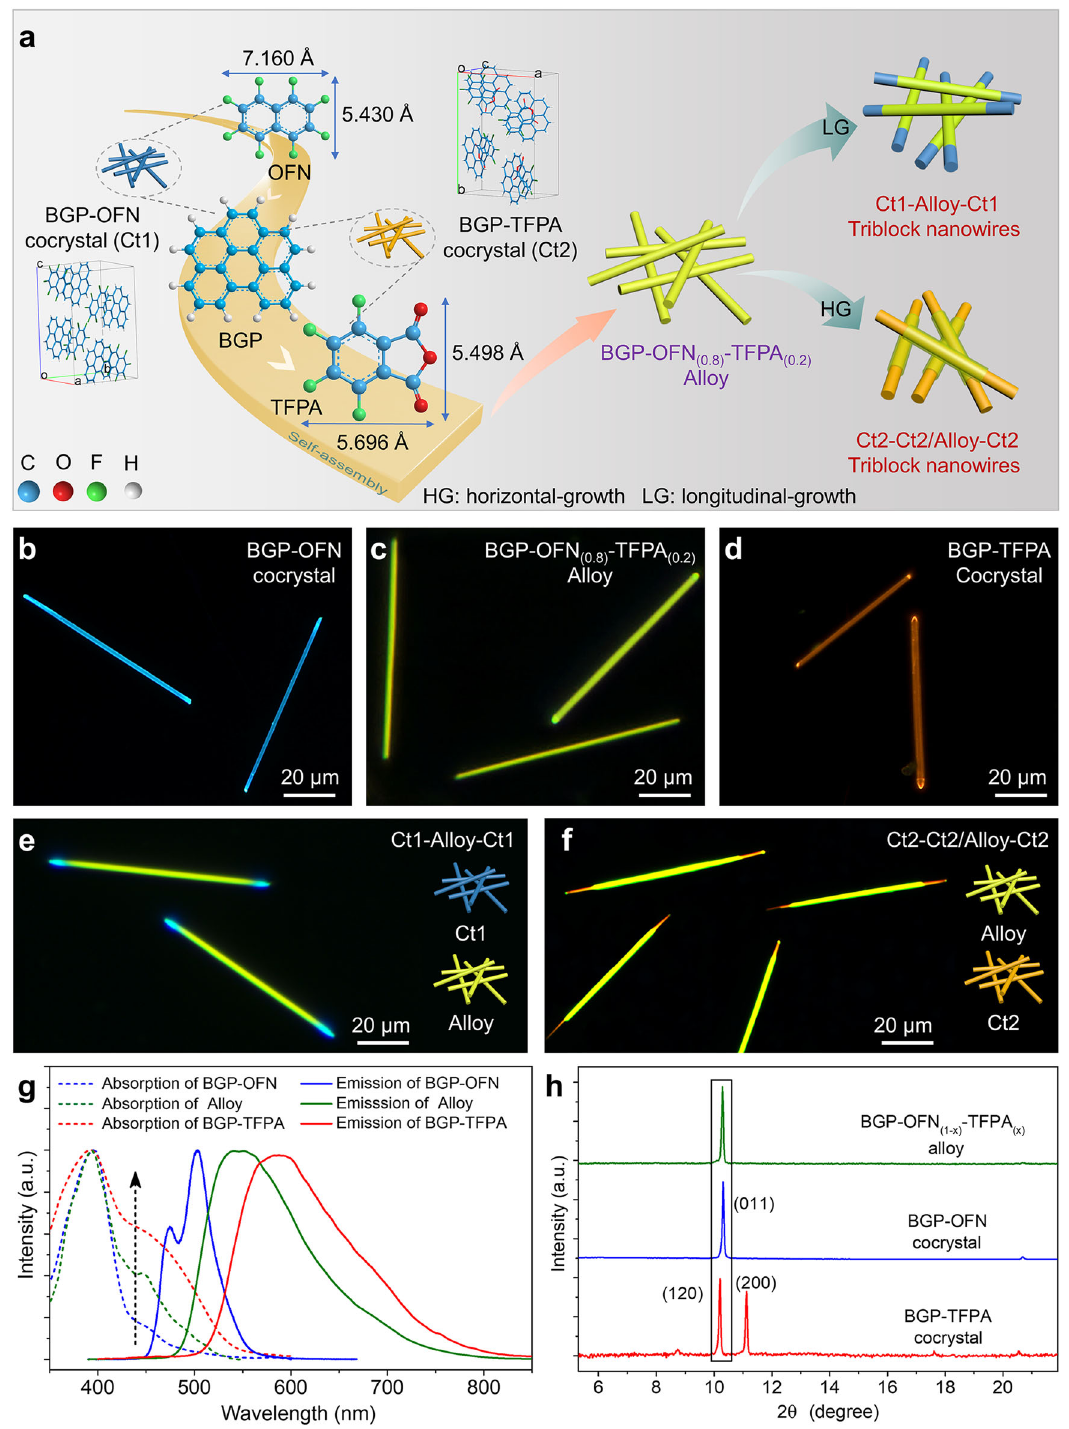
Fig. 1 Synthesis of two triblock heterostructures via lattice-mismatch-free growth concept. a Schematic diagram of the co-assembly of cocrystal and alloy into triblock heterostructures. b – d FM images of BGP-OFN cocrystals, BGP-TFPA cocrystals and BGP-OFN (0.8) -TFPA (0.2) alloys. e , f FM images of blue-olive-blue and orange-olive/orange-orange triblock nanowires, respectively. g , h The diffuse absorption and PL spectra of BGP-OFN, BGP-TFPA and BGP-OFN (0.8) -TFPA (0.2) alloy, and its corresponding XRD BGP-OFN co-crystals presents two emission peaks at around alloy structures. Figure 1d exhibits the FM images of the BGP- 473 nm and 500 nm (blue solid curves) due to the AP interaction, OFN (0.8) -TFPA (0.2) , the nanowire with the bright olive-emitting whereas, BGP-TFPA co-crystals display a single band at 590 nm under UV light. To obtain more information of the BGP-OFN, (red solid curves) owing to the CT interaction. Moreover, the PL BGP-TFPA and BGP-OFN (0.8) -TFPA (0.2) alloys, the photolumi- spectrum of the BGP-OFN cocrystal exhibits a large overlap with nescence (PL) and absorption spectroscopy was performed on the the absorption spectrum of the BGP-TFPA cocrystal in the three types of crystals. As shown in Fig. 1g, the PL spectrum from